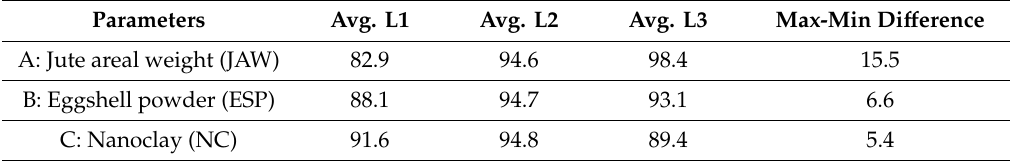
Table 8. Average and max–min variation between the di ff erent factors and